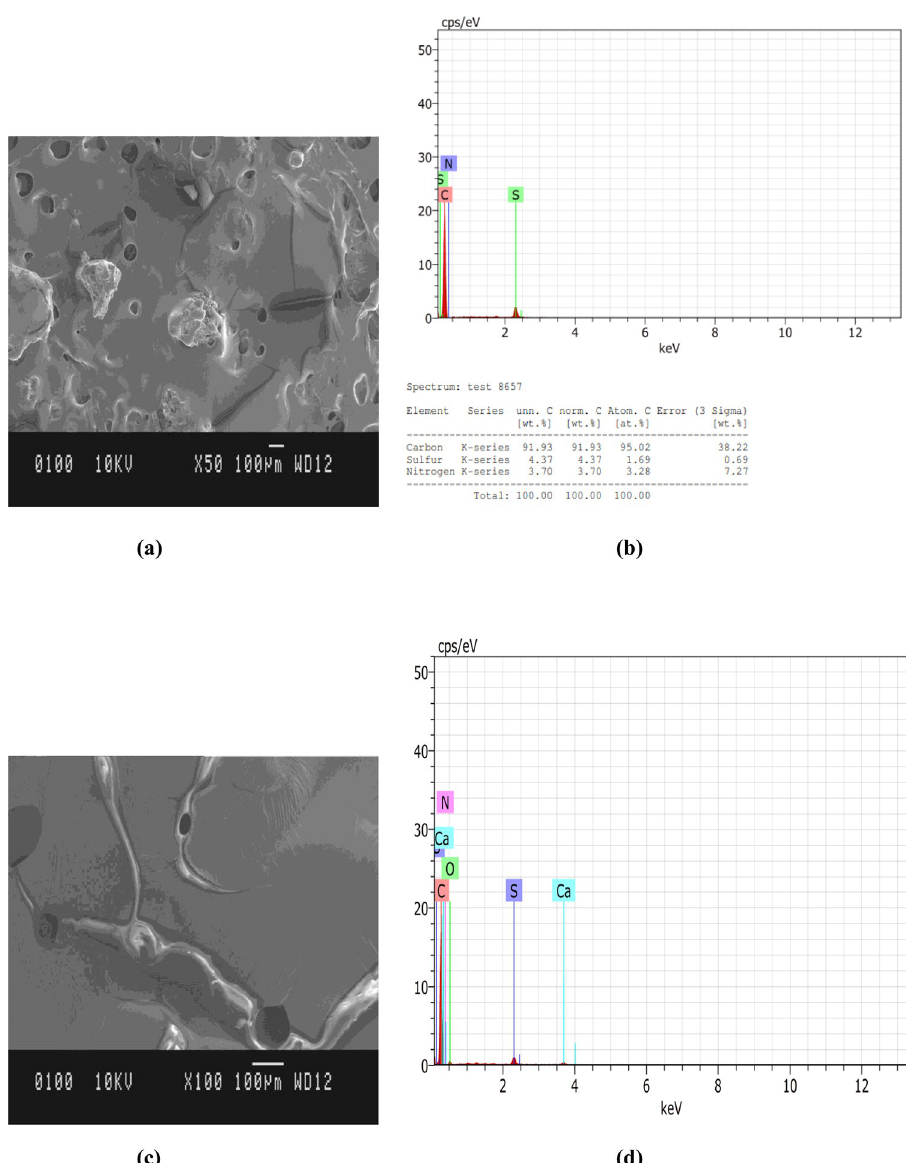
Fig 7. Modified bitumen sample S1 (a) SEM image at magnification X50; (b) EDS; (c) SEM image of sample S34 at magnification X100; (d) EDS of sample S34.